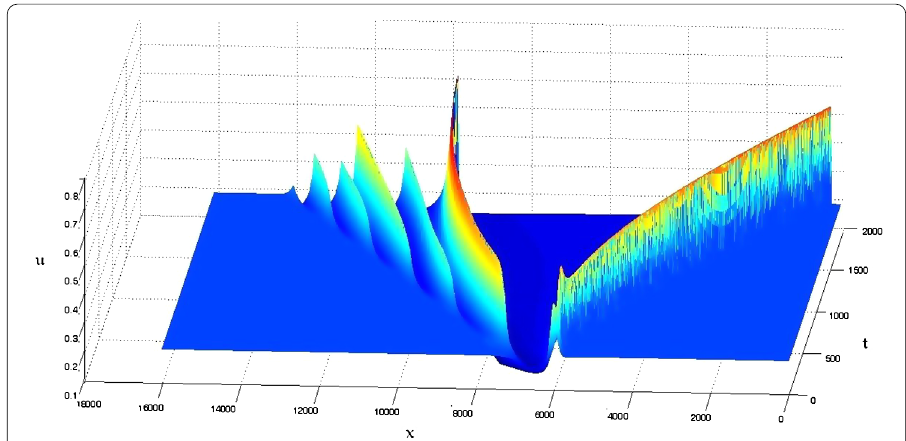
Figure 1 The classical CNFD solutions for 0 ≤ x ≤ 16,000 and 0 ≤ t ≤ 2000